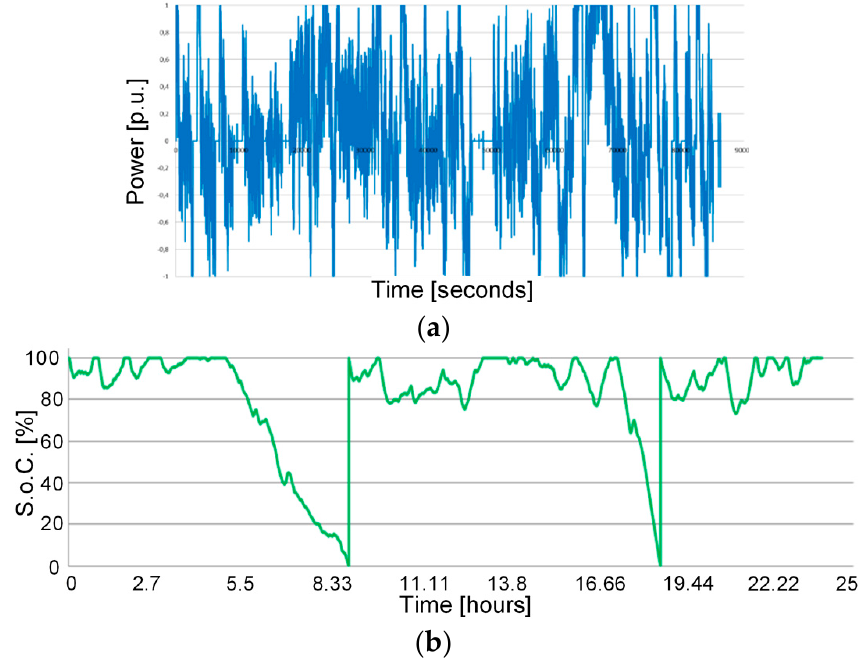
Figure 3. ( a ) exchanged power in p.u. (per unit) during a regulation frequency cycle; ( b ) S.o.C. behaviour. All manufacturers have adhered to the procedure shown in the flow-chart of Figure 4.